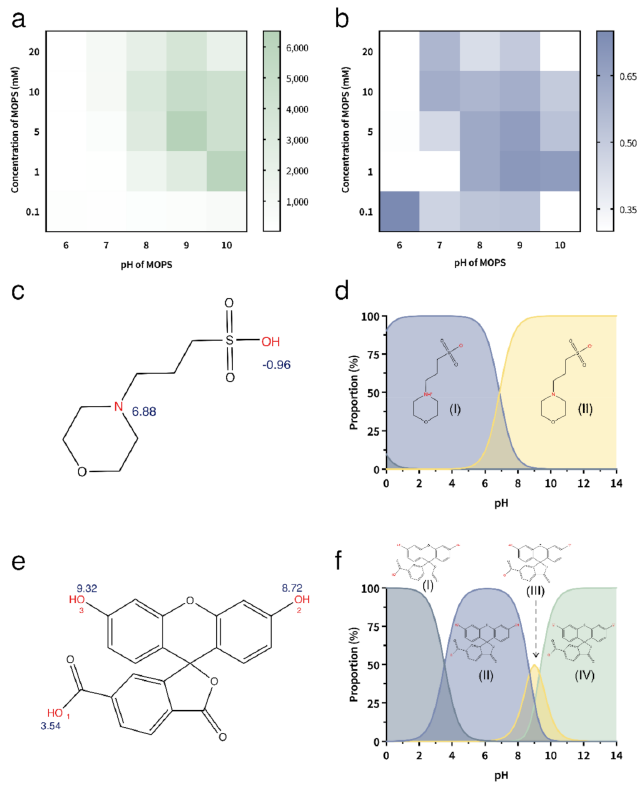
Figure 3. Interactive effect of concentration and pH of MOPS on ( a ) fluorescence quenching ( ∆ F ) and ( b ) fluorescence quenching efficiency ( ∆ F / F 0 ). ( c ) MOPS molecule with p K a values of O and N sites and ( d ) distribution of its major charged microspecies upon varied pH. ( e ) FAM fluorophore molecule with p K a values of O sites and ( f ) distribution of its charged microspecies upon varied